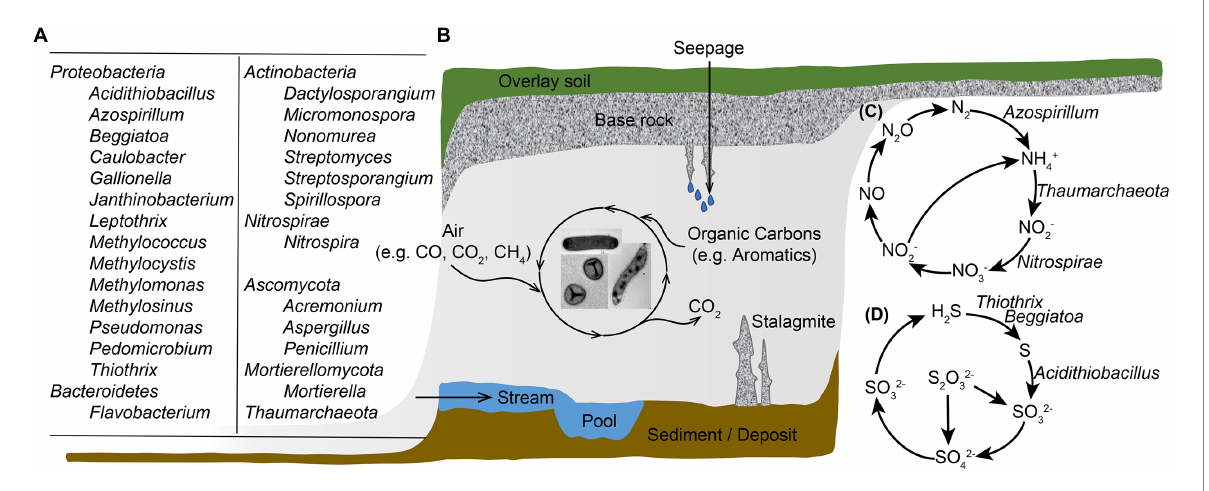
FIGURE 1 Illustration of microbial diversity and geobiochemical cycling of elements in a karst cave ecosystem. (A) Major cave microbial groups that are abundant and/or actively participate in biogeochemical cyclings; (B) Cave landscape and microbial carbon metabolisms; (C) Microbe-involved nitrogen transformation processes in caves; (D) Microbe-associated sulfur metabolisms in cave ecosystems. Microbes involved in goebiocycling processes in panels (C,D) are showed, except those genes were documented in cave samples yet no major microbial taxa responsible for the process was